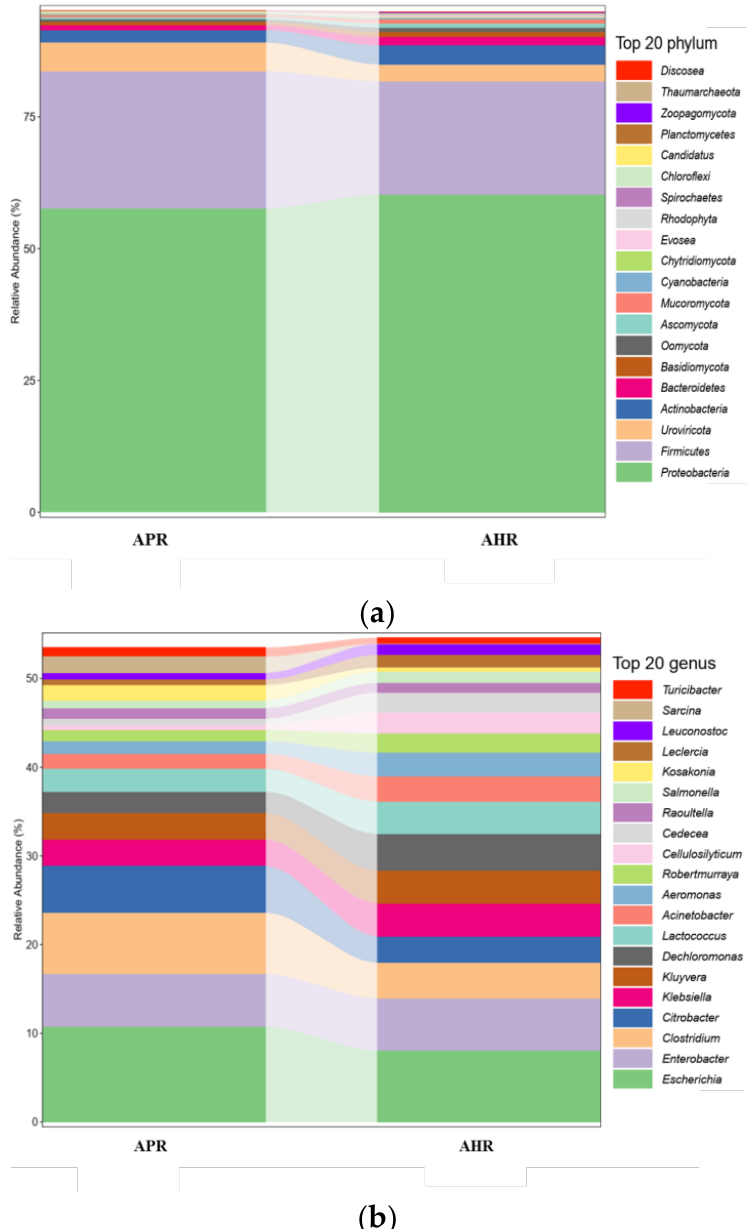
Figure 1. Column chart of relative abundance at the phylum ( a ) and genus levels ( b ) in fecal microbiota of captive giant pandas adopting different nursing methods. Note: In the figure, the abscissa is arranged according to the sample name, each bar represents a sample, and each taxon is distinguished by color, and the ordinate represents the relative abundance of each taxon, the longer the bar, the higher the relative abundance.